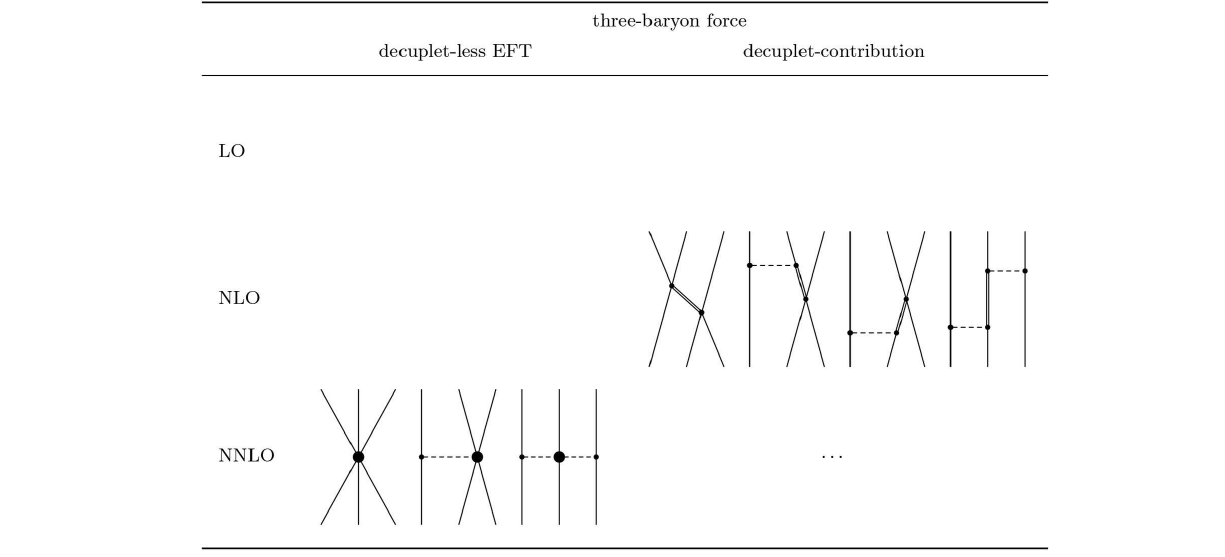
FIGURE 10 | Hierarchy of three-baryon forces with explicit introduction of the baryon decuplet (represented by double lines).